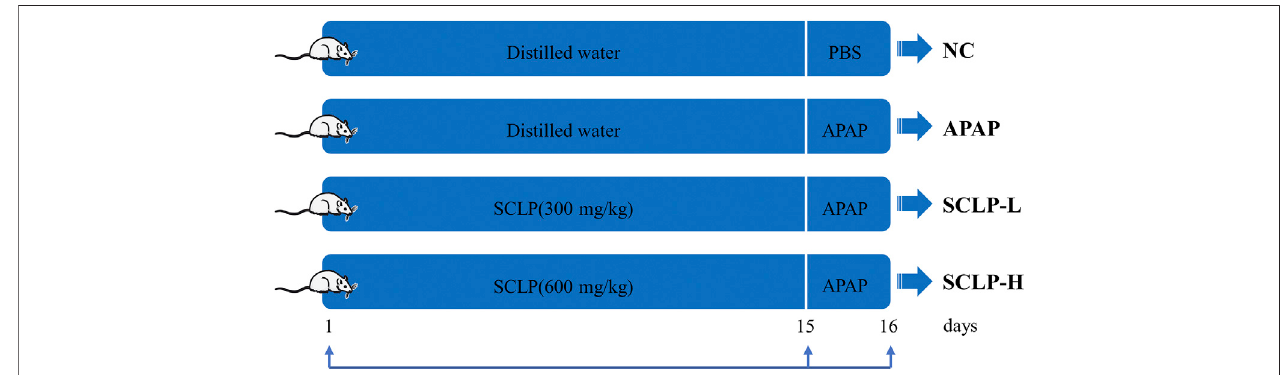
FIGURE 1 | Animal experimental design. NC: normal control group; APAP: APAP model group; SCLP-L: AILI mice treated with SCLP (300 mg/kg); SCLP-H: AILI mice treated with SCLP (600